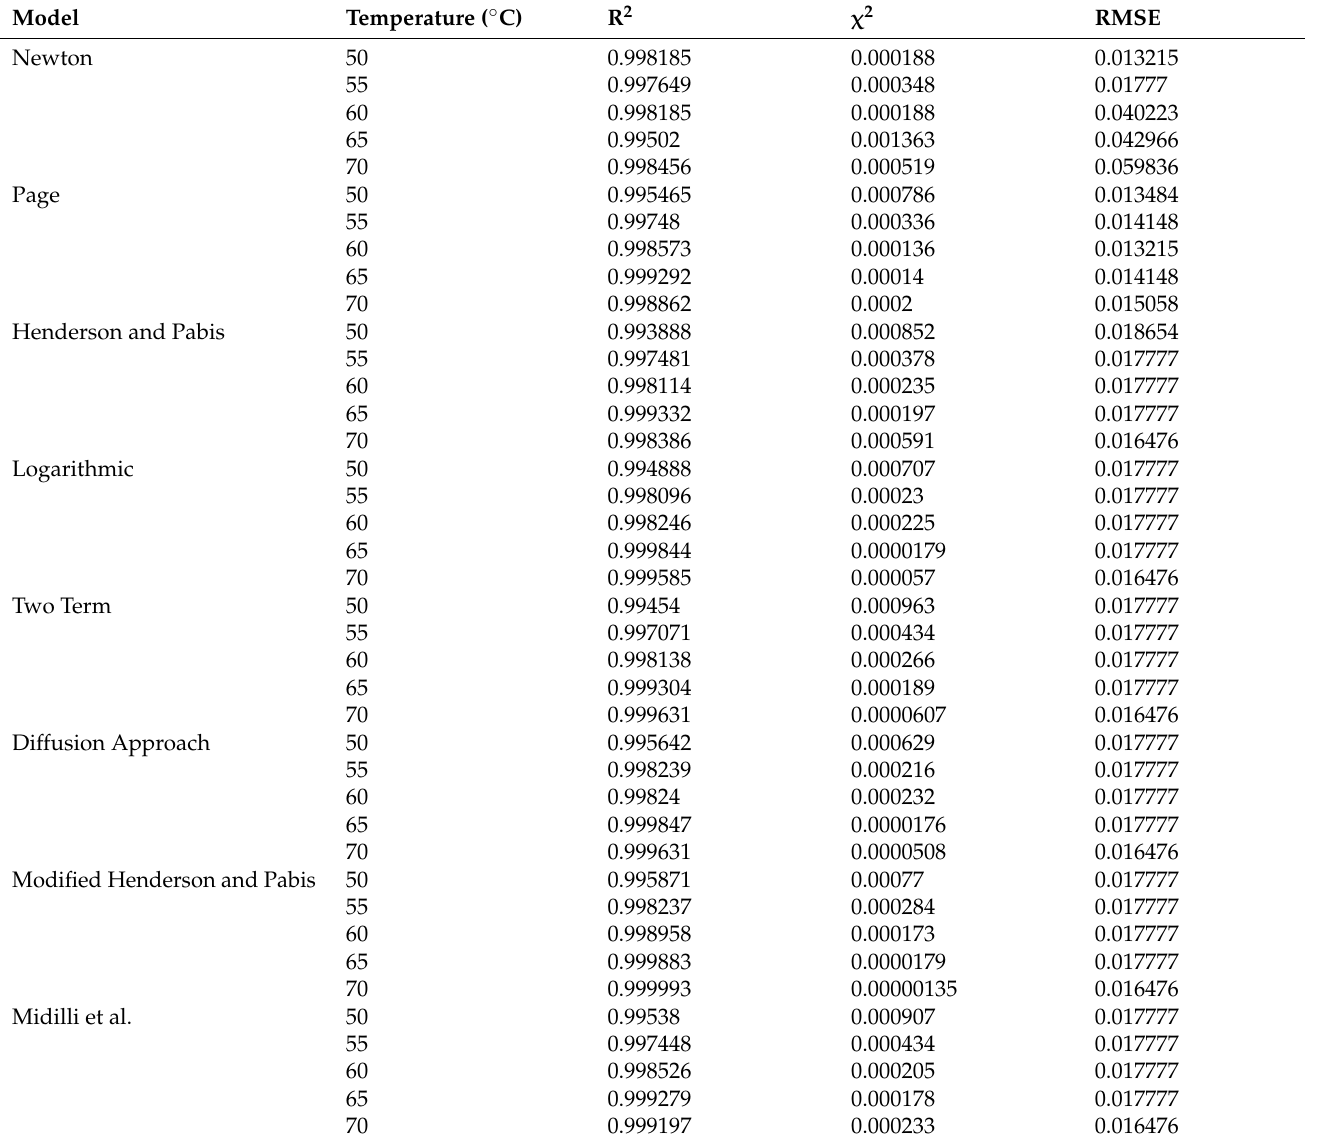
Table 2. Statistical results of eight mathematical models at different drying conditions and constant bed